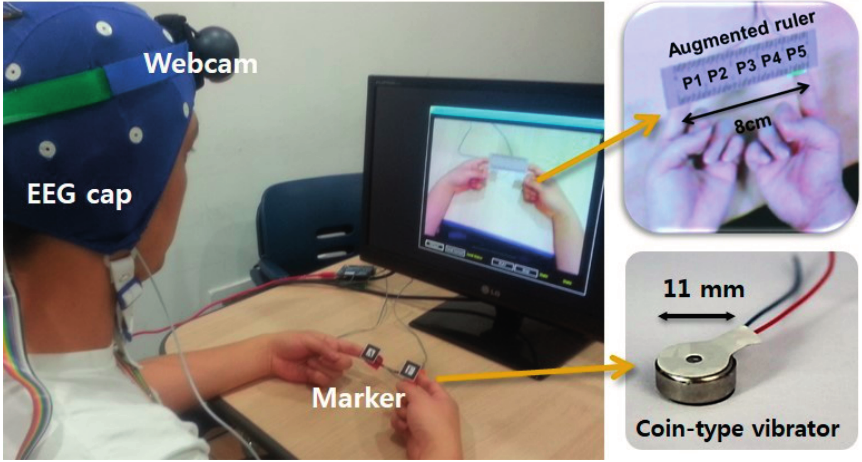
Figure 4. The experimental set up for experiment. Vibratory stimulations were given to the two index fingers, and a user watched the monitor where an augmented virtual ruler was placed on the fingers. An EEG cap was used to measure and document the brain